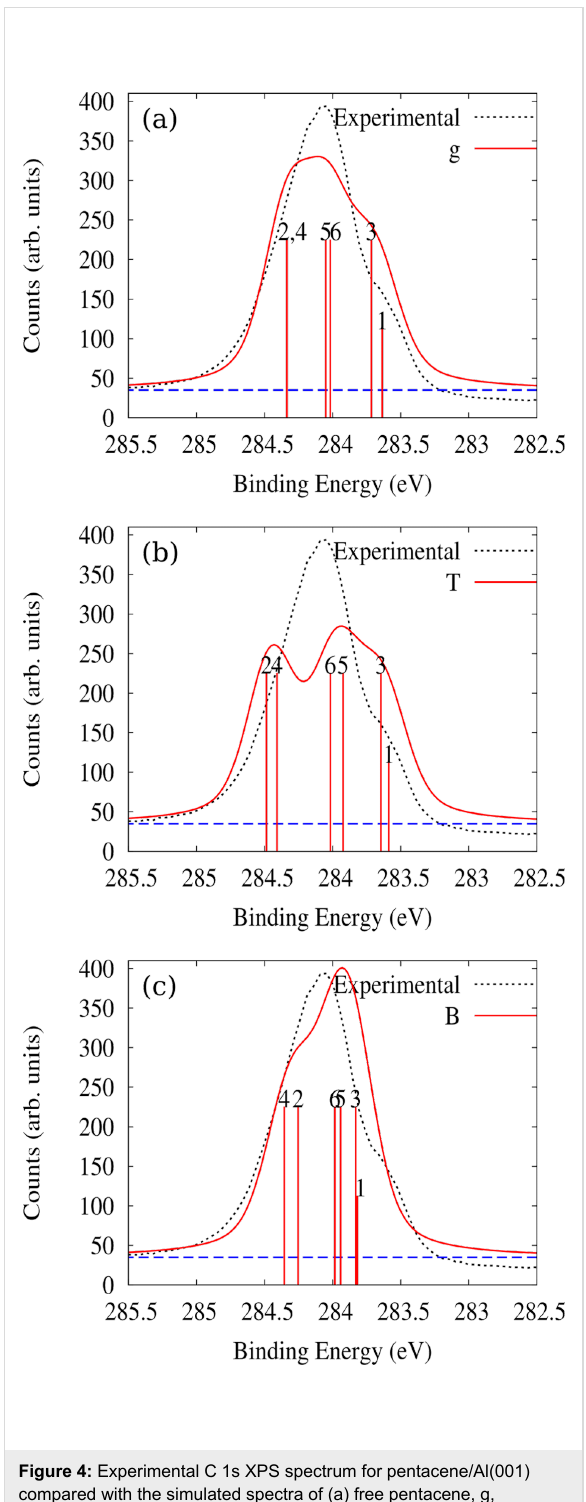
Figure 4: Experimental C 1s XPS spectrum for pentacene/Al(001) compared with the simulated spectra of (a) free pentacene, g, (b) pentacene at the T site and (c) pentacene at the B site. The indi- vidual contributions from the six non-equivalent carbon atoms are shown as vertical bars. These are convoluted with pseudo-Voigt profiles with 0.52 eV Lorentzian and 0.36 eV Gaussian full widths at half maximum and offset by a constant (see the dashed blue line) to obtain the simulated spectra (solid red